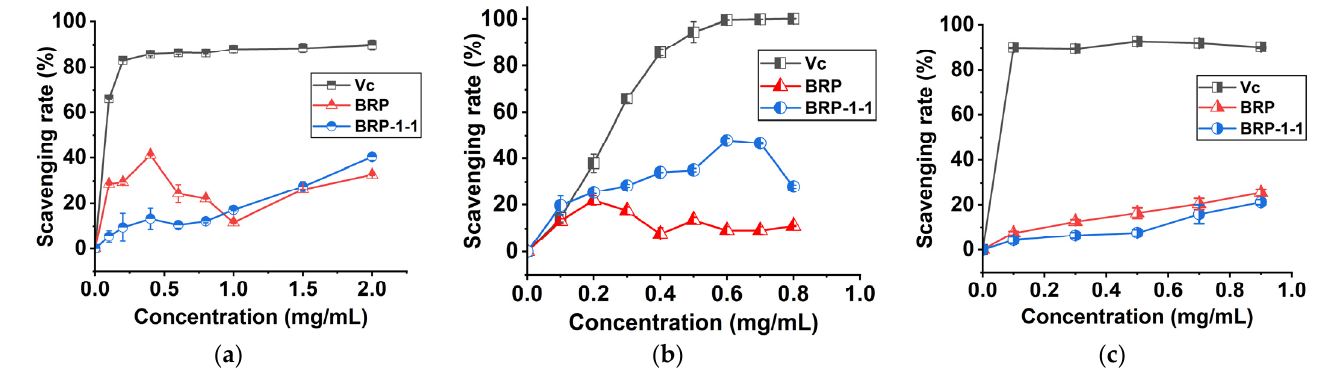
Figure 6. ( a ) DPPH + scavenging rate; ( b ) hydroxyl scavenging rate; ( c ) ABTS + scavenging